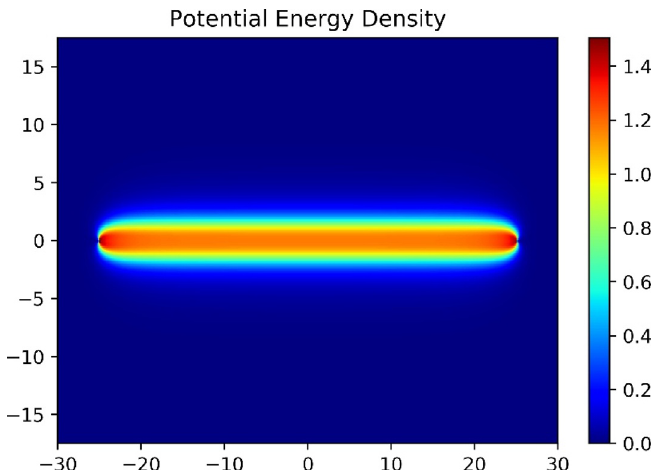
Figure 7. Single string for N = 8 with quarks of weight w 1 and separation of R = 50 . This can be interpreted as the collapse of two strings due to the DWs’